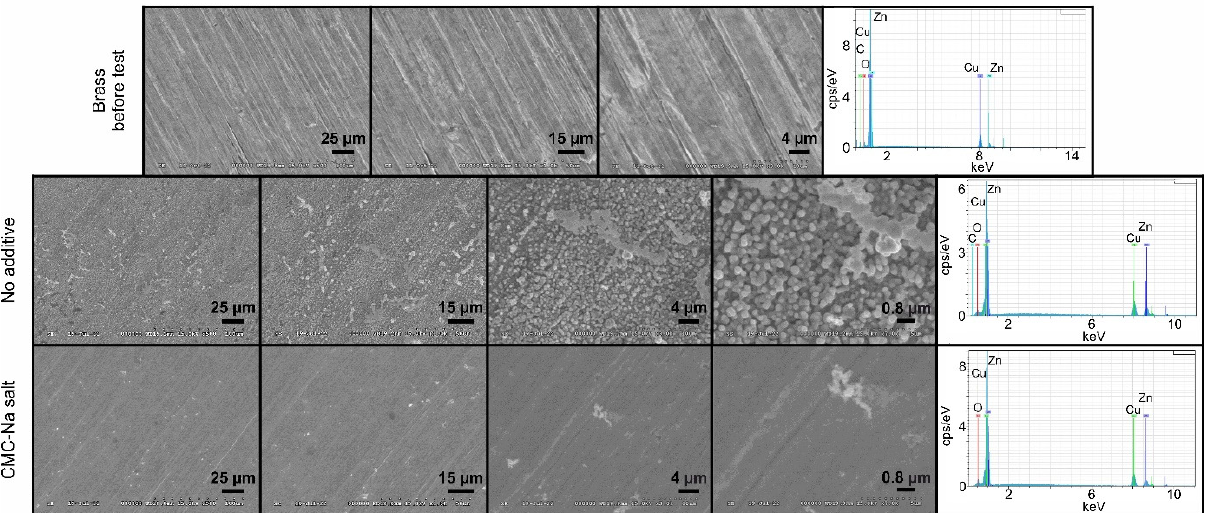
Figure 8. The SEM images and the EDS spectra of the brass anode, after the long-term cyclic performance test in different magnifications, in the absence and presence of CMC-Na salt additive in the electrolyte.